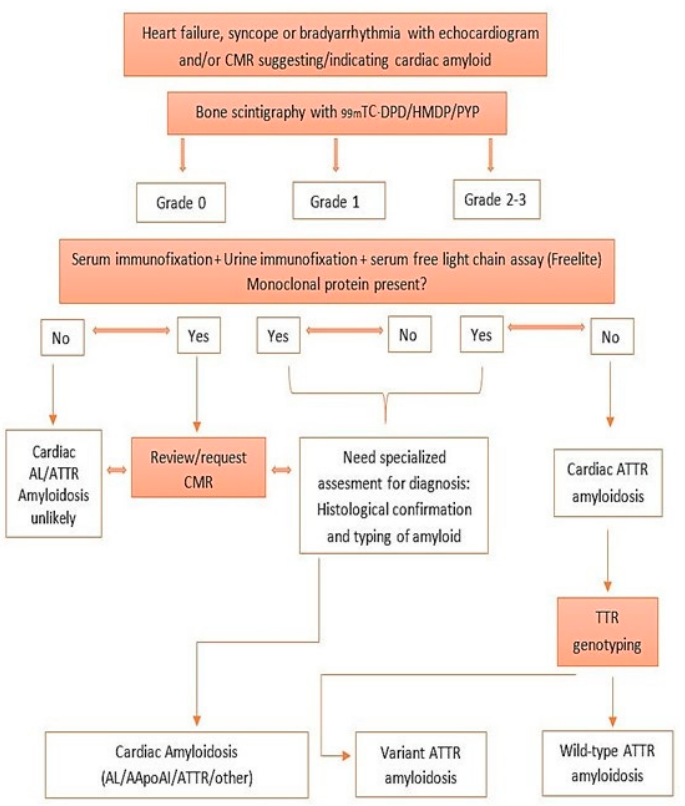
Figure 6. Consensus algorithm for non-invasive diagnosis of cardiac amyloidosis.